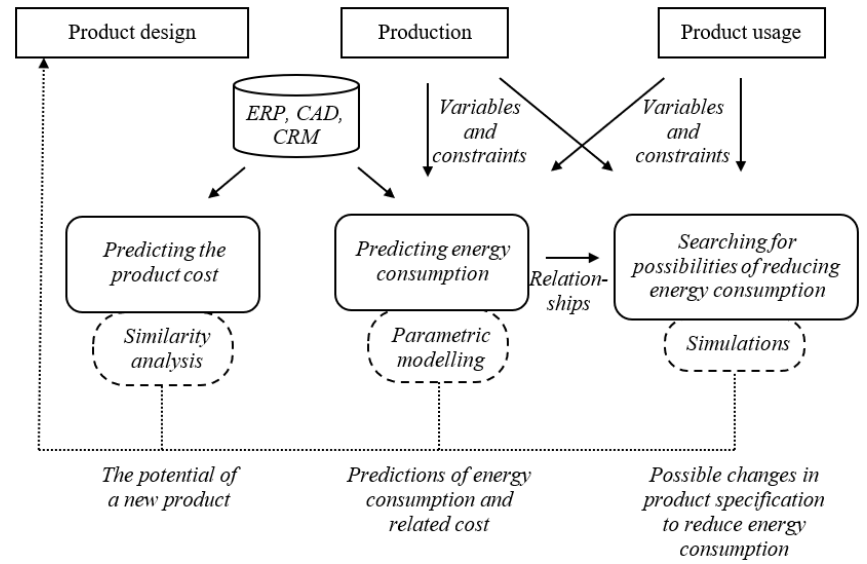
Figure 2. A framework for the proposed